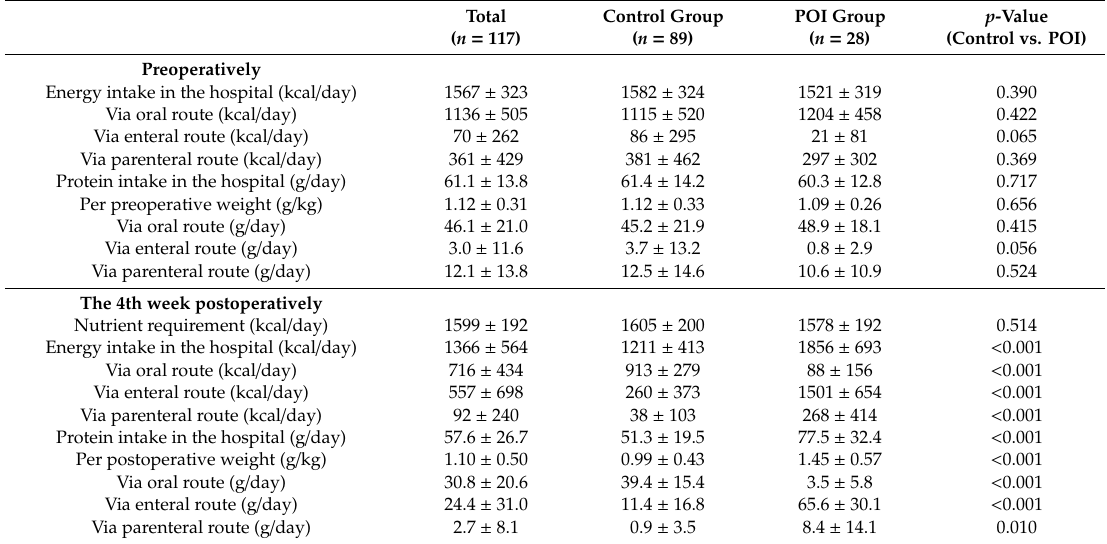
Table 2. Comparison of nutrient intake in the hospital between the study groups.